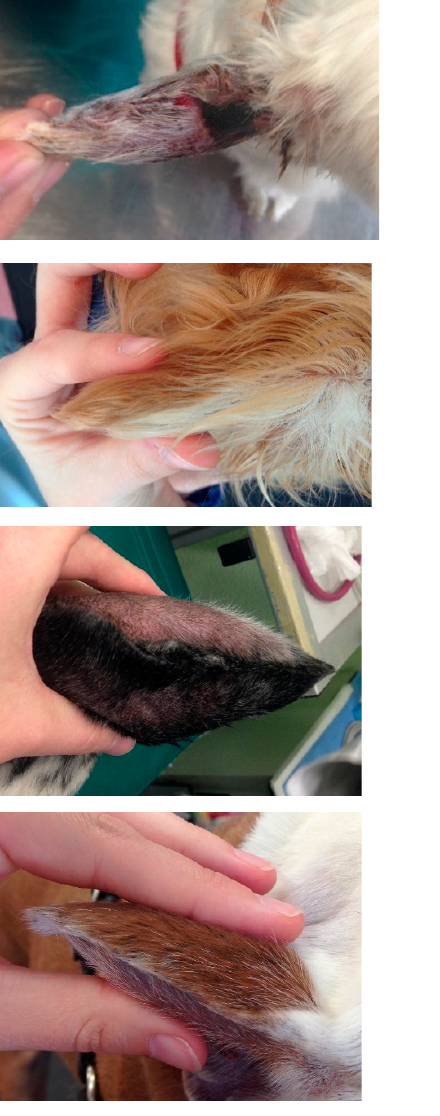
Figure 3. Macroscopic images of the pinna of four cases (dog 3, 10, 12 and 13) at D0 ( left ) and D42 ( right ).